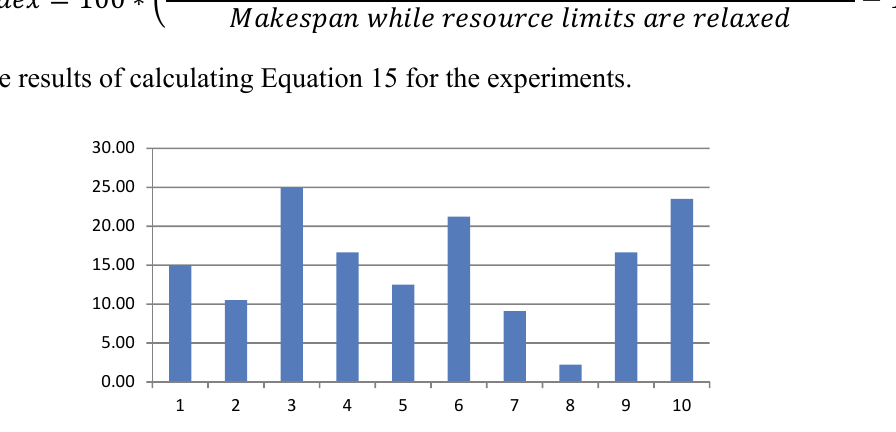
Fig. 9. Makespan index graph for the solved